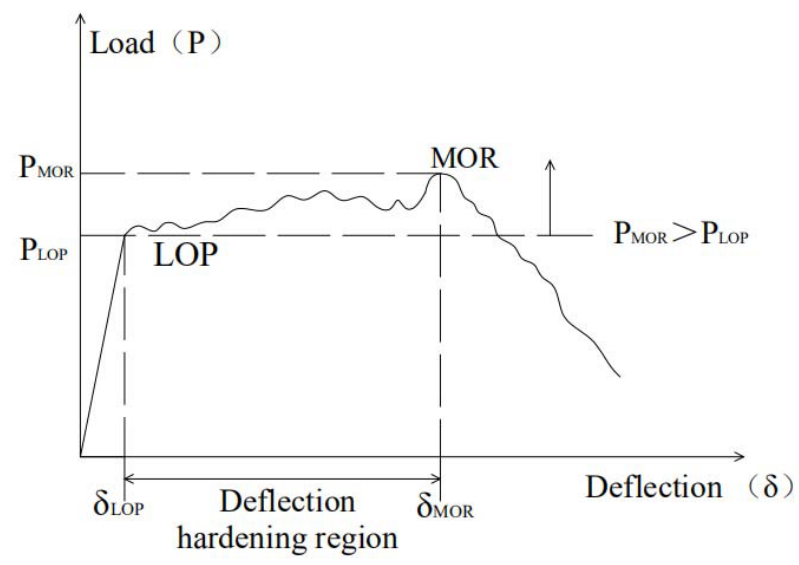
Figure 5. Typical strain hardening curve of fiber-reinforced cement-based composites. (1) Strength